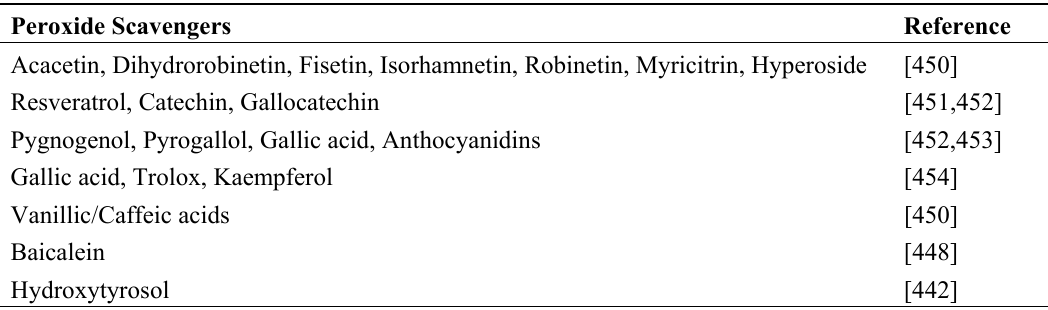
Table 7. Peroxide